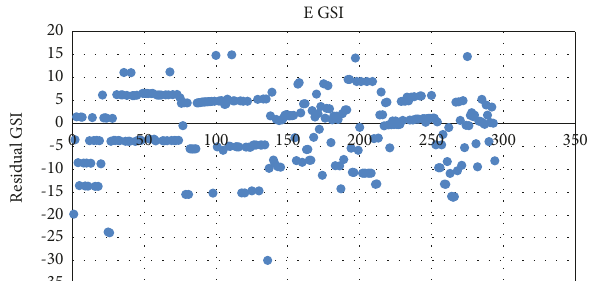
Figure 8: Graph showing the comparison between mapped GSI and GSI predicted by (1) in Gorgan